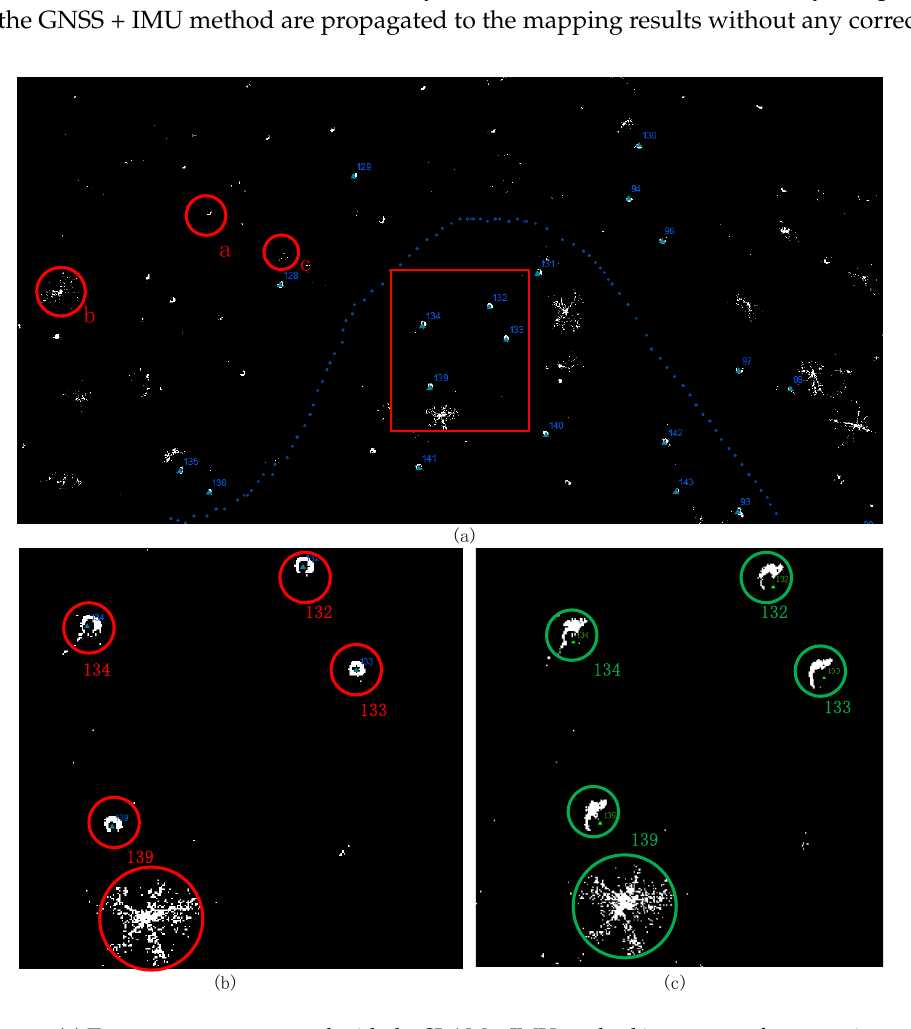
Figure 13. ( a ) Tree stem map generated with the SLAM + IMU method in a mature forest environment; ( b ) map generated with the SLAM + IMU method in the red rectangle area; ( c ) map generated with the GNSS + IMU method in the red rectangle area (white dots are the laser point cloud).